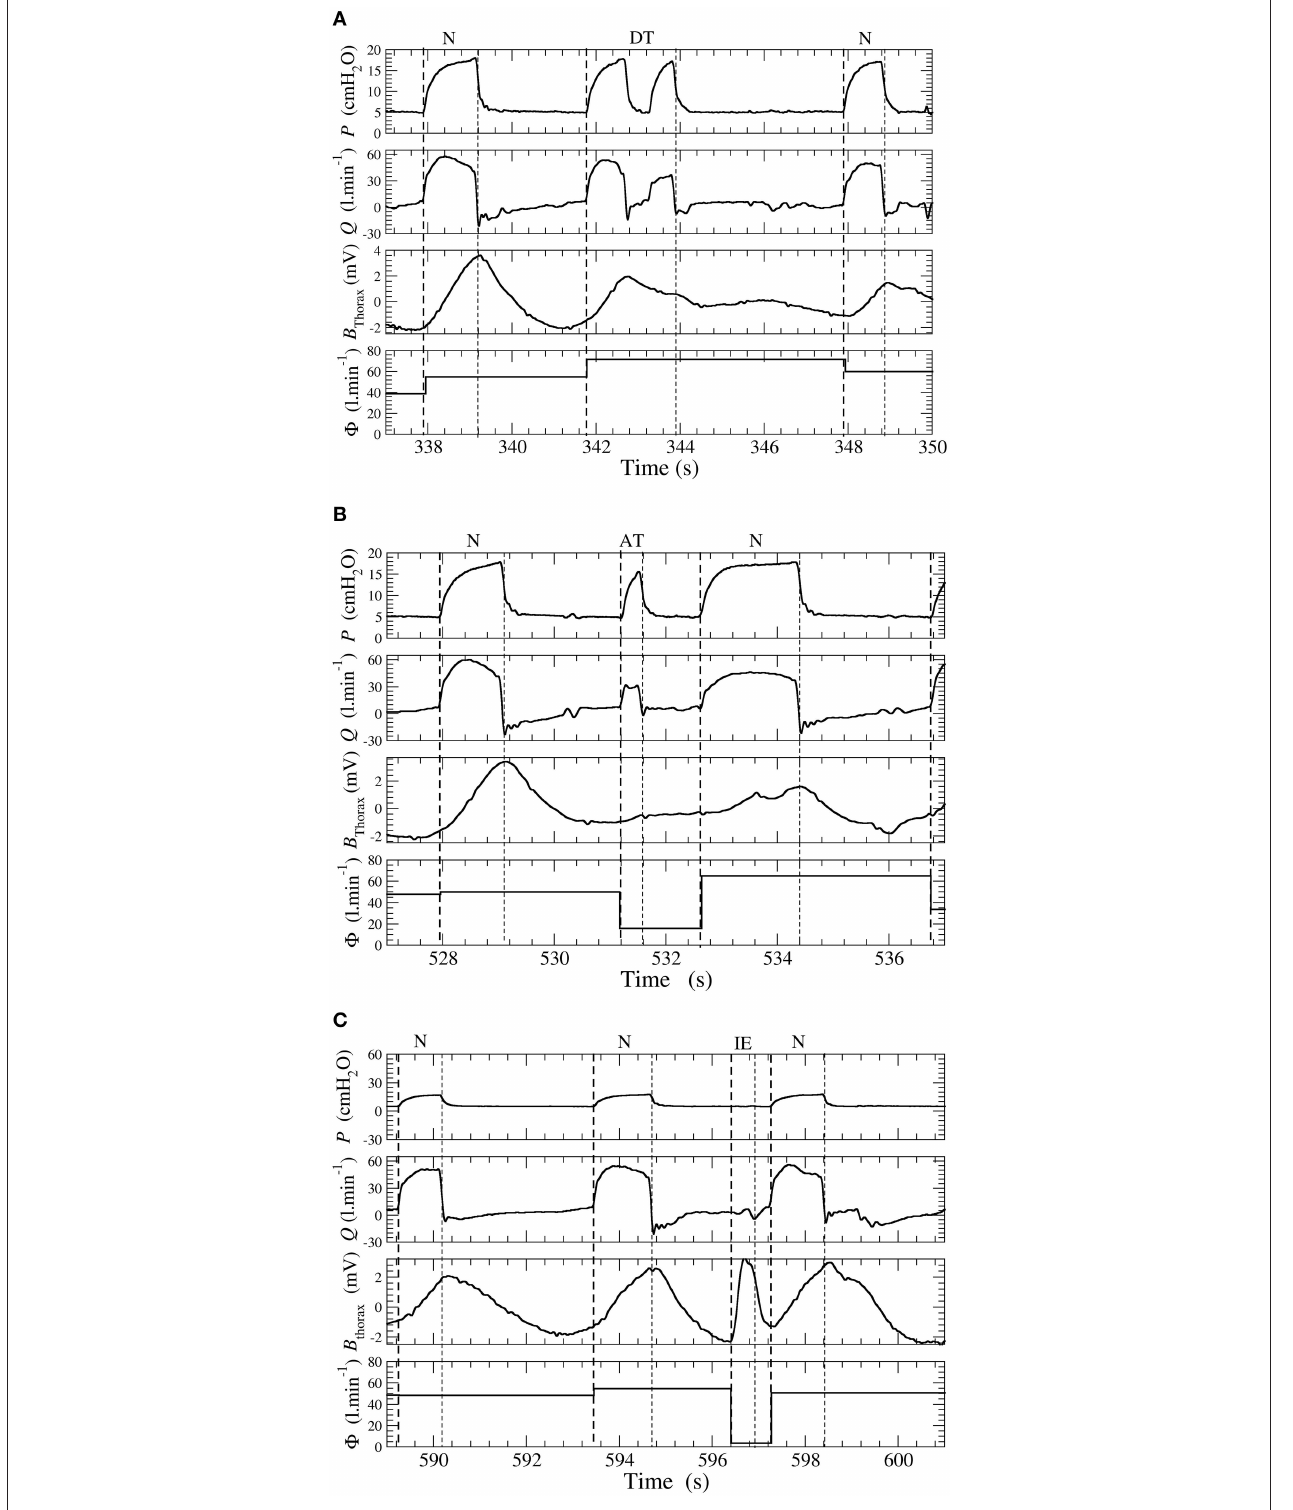
FIGURE 2 | (A) Double-triggering. (B) Auto-triggering. (C) Ineffective effort. Examples of double-triggering (DT), auto-triggering (AT), and ineffective efforts (IEs) in a patient ventilated with a pressure support ventilation (PSV) mode. Waveforms of pressure P , flow Q , thoracic belt B thorax , and total leakage 8 .